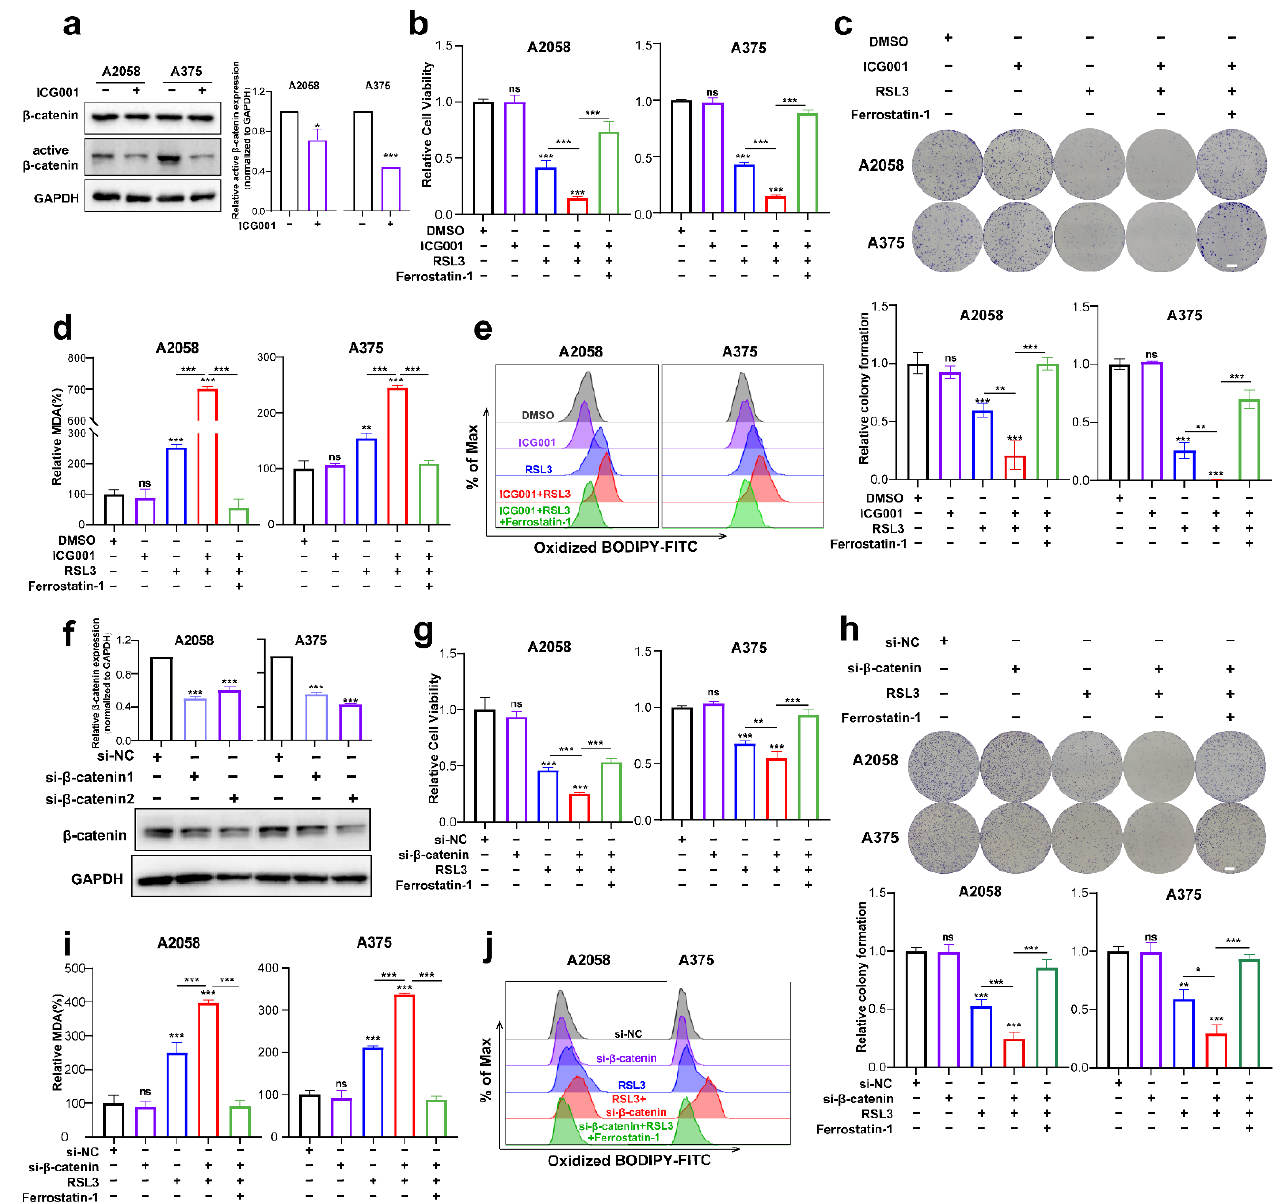
Figure 2. Targeting Wnt/ β -catenin signaling exacerbates melanoma cell ferroptosis by promoting lipid peroxidation in vitro. ( a ) Immunoblotting analysis of β -catenin and active β -catenin levels in response to 6 µ M ICG001 treatment for 24 h in both melanoma cell lines. ( b , c ) Relative cell viability and colony formation after the indicated treatment for 24 h in both melanoma cell lines (RSL3, 2 µ M for A2058 and 0.5 µ M for A375; 6 µ M ICG001 and 10 µ M Ferrostatin-1 for both A2058 and A375). Scale bars = 5 mm. ( d ) Intracellular MDA levels with the indicated treatment related to ( b ). ( e ) Lipid ROS levels of indicated cells were detected utilizing flow cytometry and employing C11-BODIP. ( f ) The knockdown efficiency of β -catenin in A2058 and A375 melanoma cell lines via immunoblotting analysis. ( g , h ) Relative cell viability and colony formation after the indicated treatment for 24 h in both melanoma cell lines with the knockdown of β -catenin (RSL3, 2 µ M for A2058 and 0.5 µ M for A375 and 10 µ M Ferrostatin-1 for both A2058 and A375). Scale bars = 5 mm ( i ) Intracellular MDA levels with the indicated treatment related to ( g ). ( j ) By flow cytometry, lipid ROS levels in indicated cells were detected employing C11-BODIPY. Data were presented as mean ± SEM of triplicates. p -value was computed using a two-tailed Student’s t -test. * p < 0.05, ** p < 0.01 and *** p < 0.001. ns, nonsignificant.